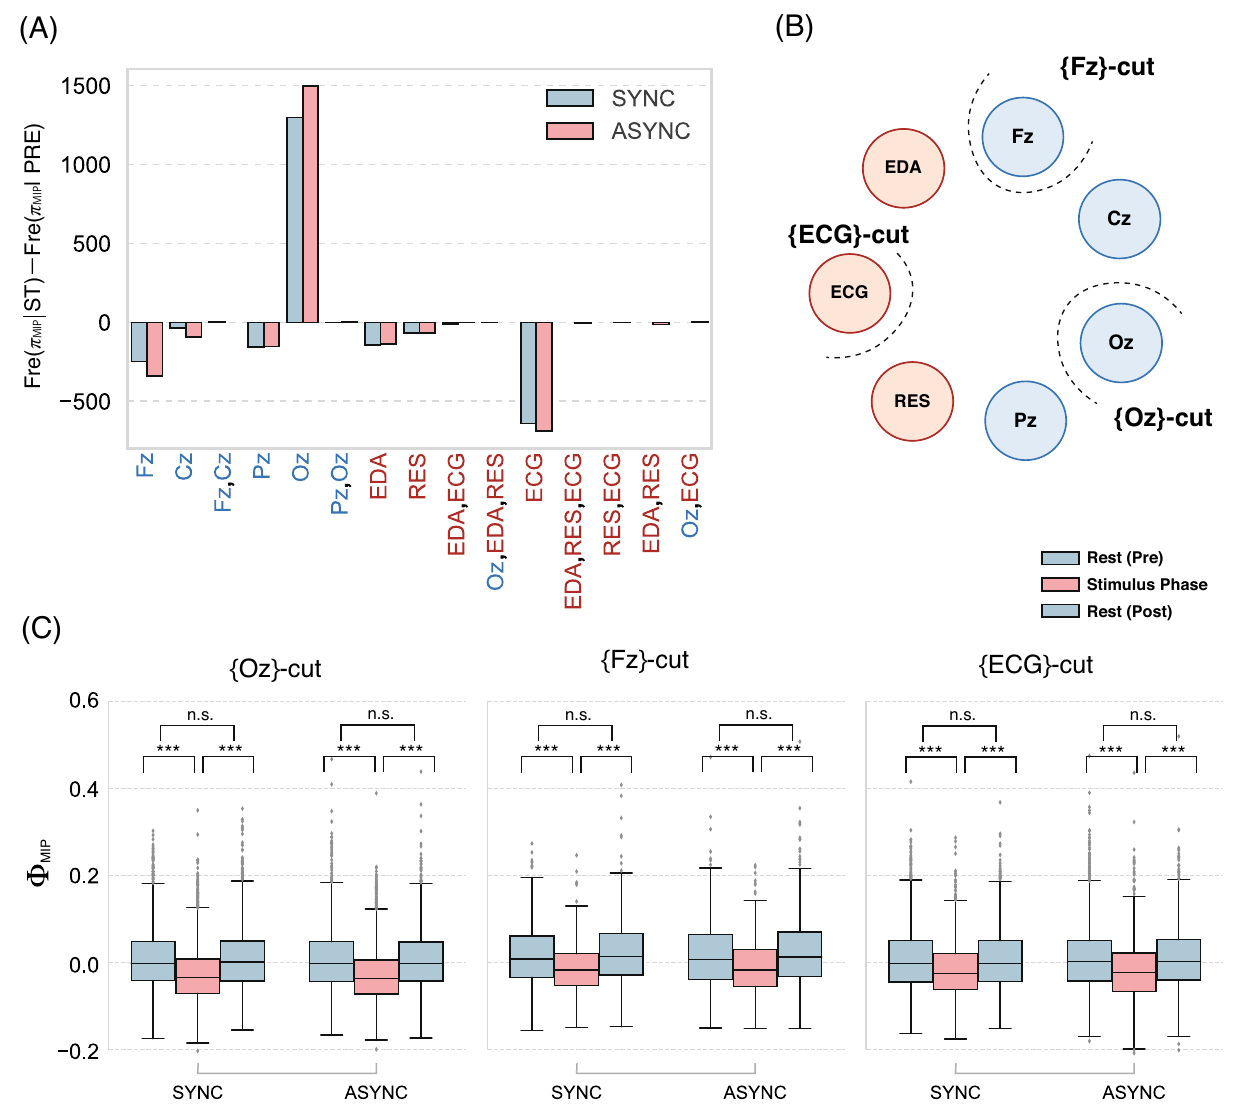
Figure 2. ( A ) Differences in the π MIP frequencies of pre- and intra-stimuli: Fr (π MIP | ST ) − Fr (π MIP | PRE ) . The computational time frame for IIT is 250 (1 s). The positive values indicate that a certain type of π MIP increases during the stimulus. Blue (red) bars show the frequency differences in the synchronous (asynchronous) condition. Blue (red) letters show data from the brain (body) system. ( B ) Image of MIP-cut location of the system S . {Oz}-, {Fz}-, {ECG}-cut are the subsets with the three largest differences shown in ( A ). ( C ) (cid:31) MIP of each MIP-cut location. In all cases, (cid:31) MIP drops during the stimulus ( ∗ p < 0.05 , ∗ ∗ p < 0.01 , ∗ ∗ ∗ p < 0.005 ). No after-effects were observed (see Tables S2 and S3 for other parameter